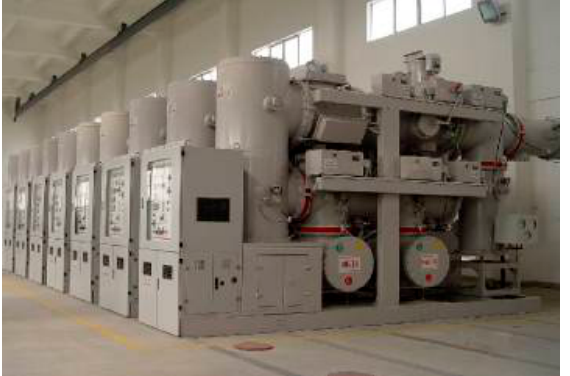
Figure 5. Electrical equipment.